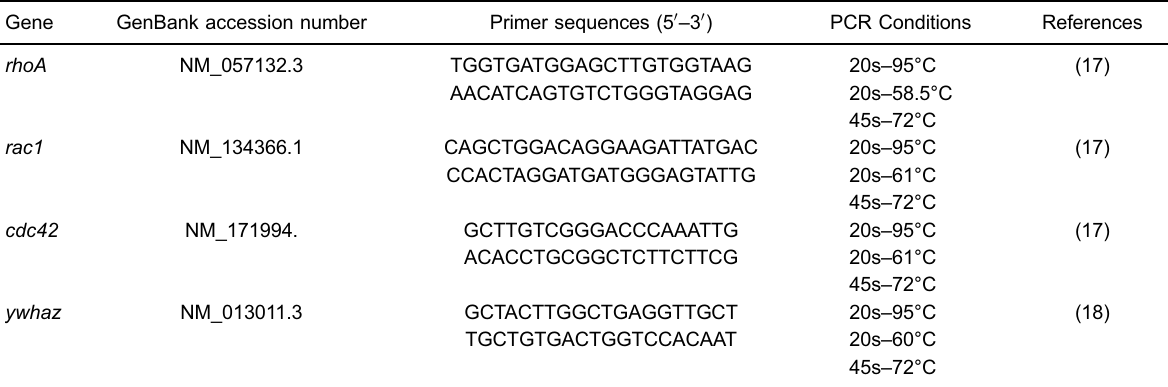
Table 2. Description of genes, GenBank accession numbers, RT-qPCR primers, and PCR conditions.